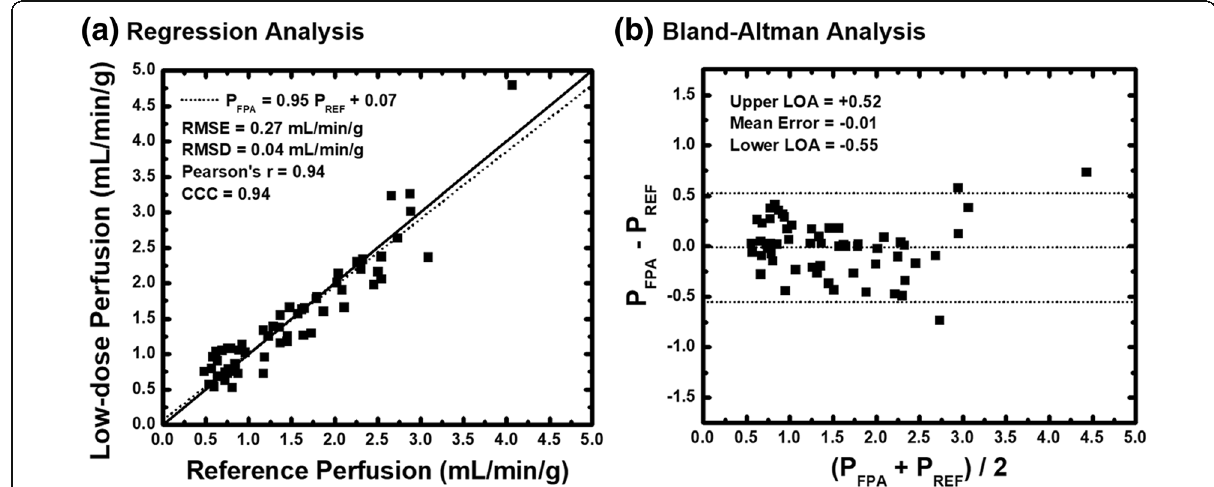
Fig. 5 Low-dose first-pass analysis (FPA) perfusion measurements as compared to the reference standard retrospective FPA perfusion measurements. A total of 60 perfusion measurements from 14 animals were assessed. a Regression analysis comparing the simulated low-dose FPA perfusion measurements to the previously validated reference standard retrospective FPA perfusion measurements is displayed. b Corresponding Bland-Altman analysis is also